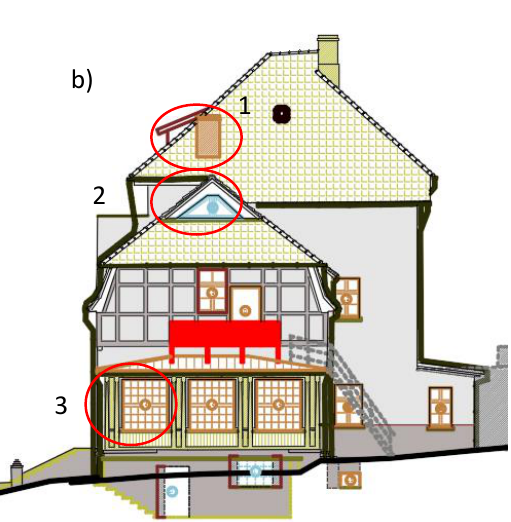
Figure 9. Southern façade of the building: a) surveys 2D drafting; b) architects 2D